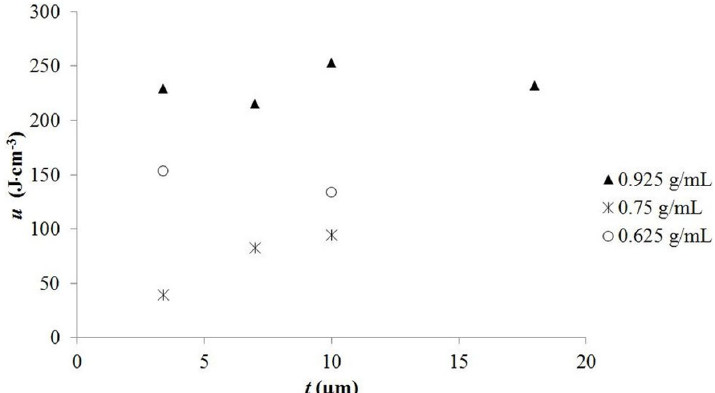
Figure 5. Energy density as a function of dielectric layer thickness. This figure shows that the energy density per dielectric volume in the “medium” voltage range is roughly independent of dielectric thickness, but is a non-linear function of salt concentration in the solution inside the tubes.